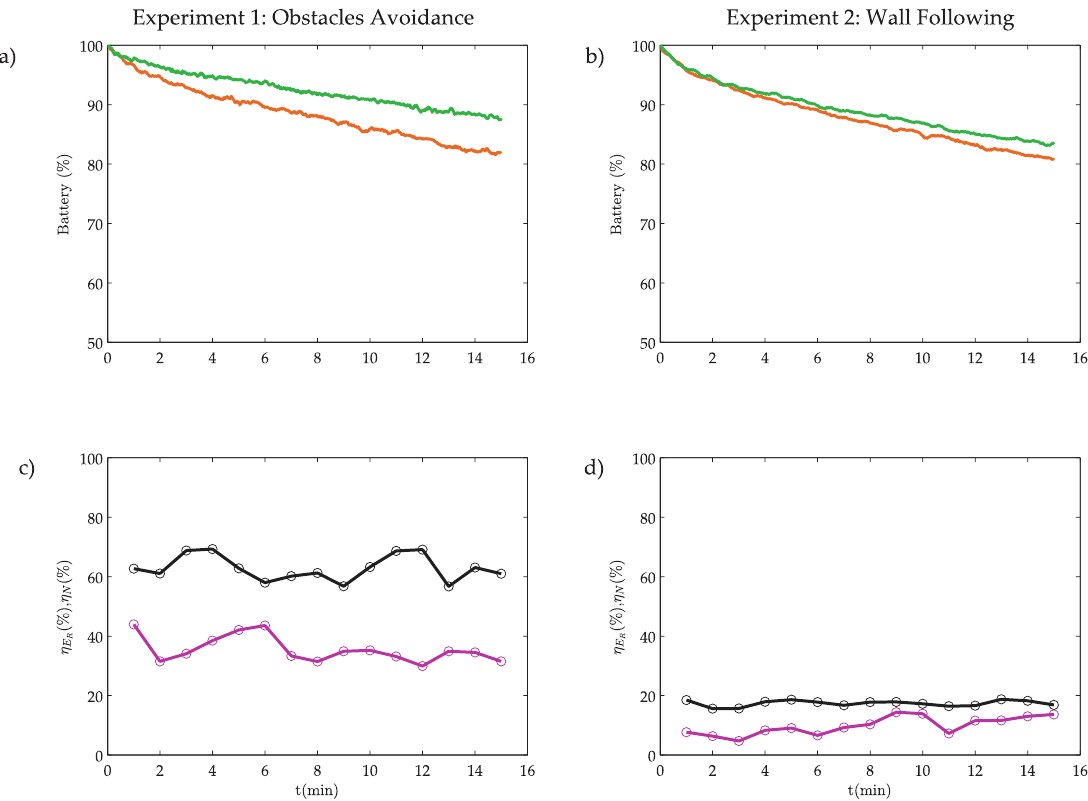
Figure 17. Energy consumption: ( a , b ) battery level, where the orange line represents the battery level in the discrete-time robot, and the green line in the event-based robot; and ( c , d ) event efficiency η N (black line) and robot energy efficiency η CL (pink